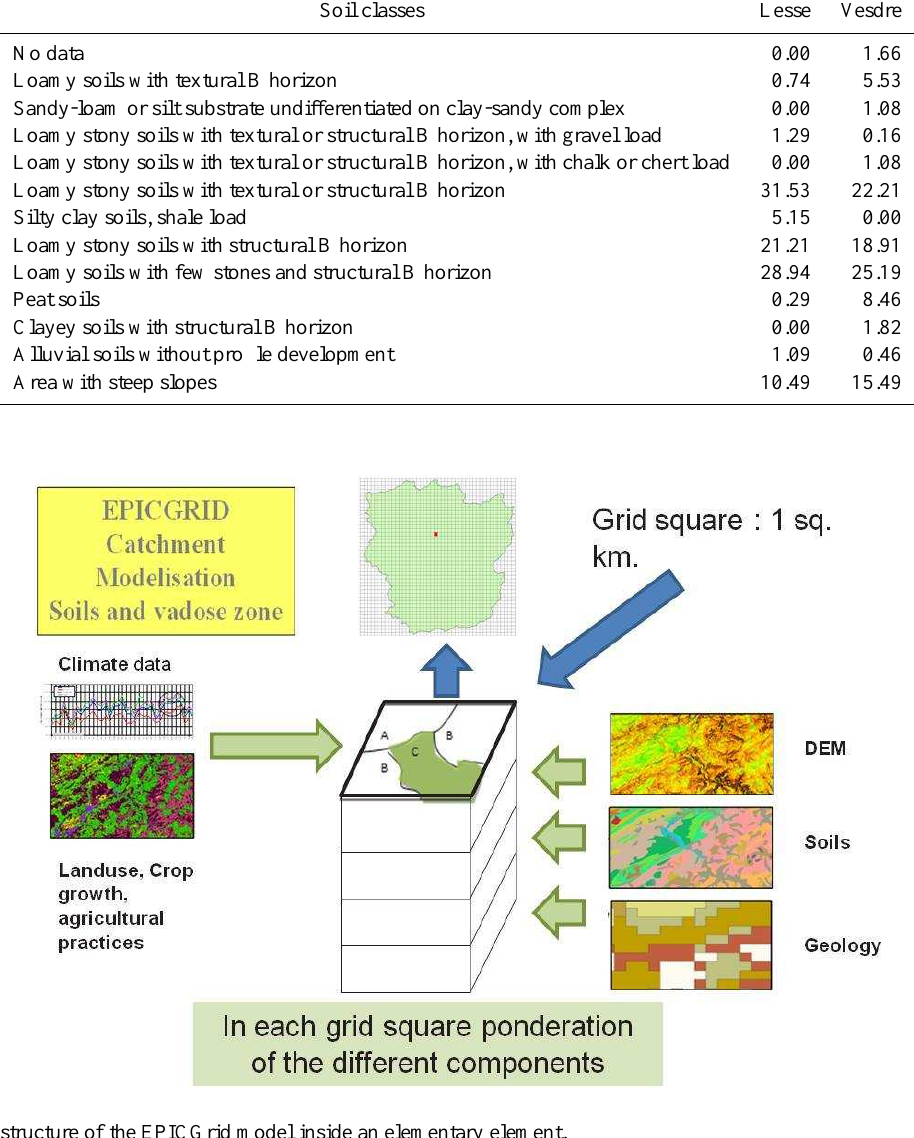
Fig. 2. Simulation structure of the EPICGrid model inside an elementary